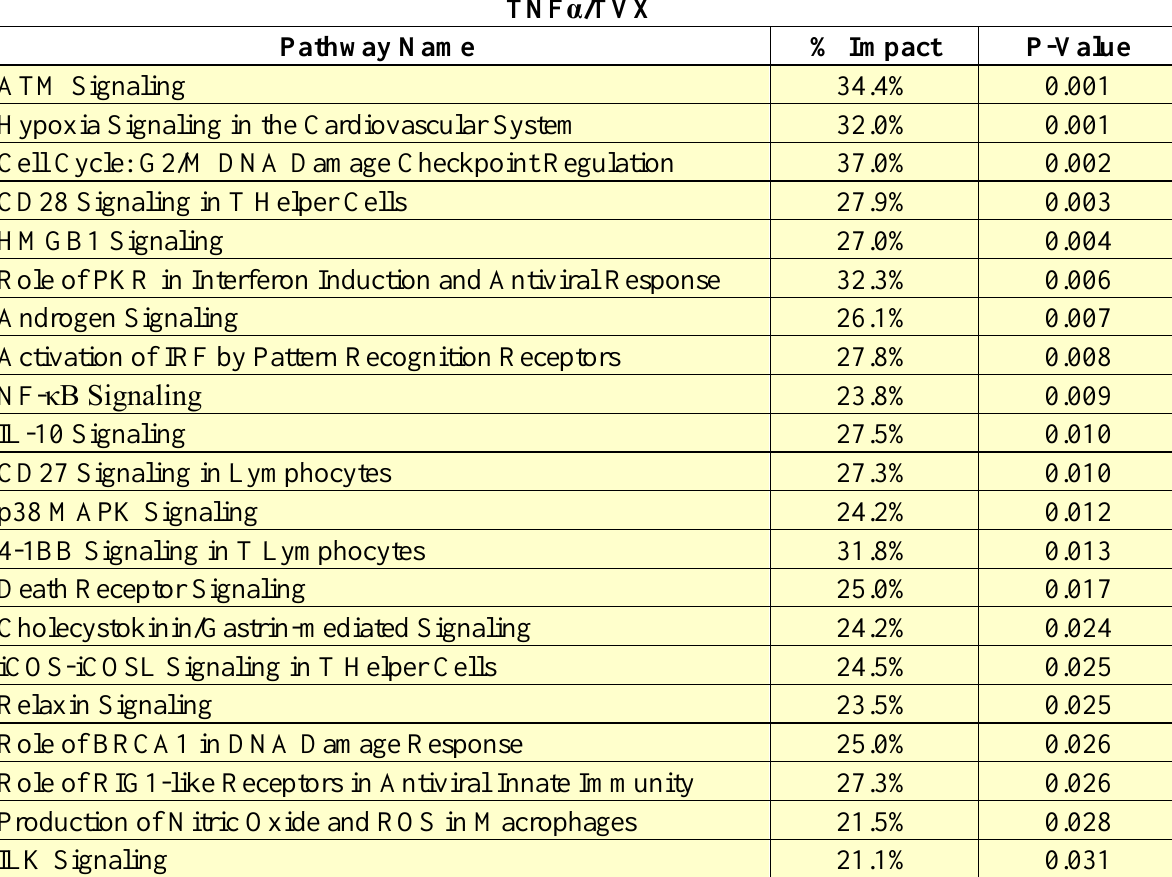
Table 2. List of Biochemical Pathways Regulated by TNFα/TVX, but not by